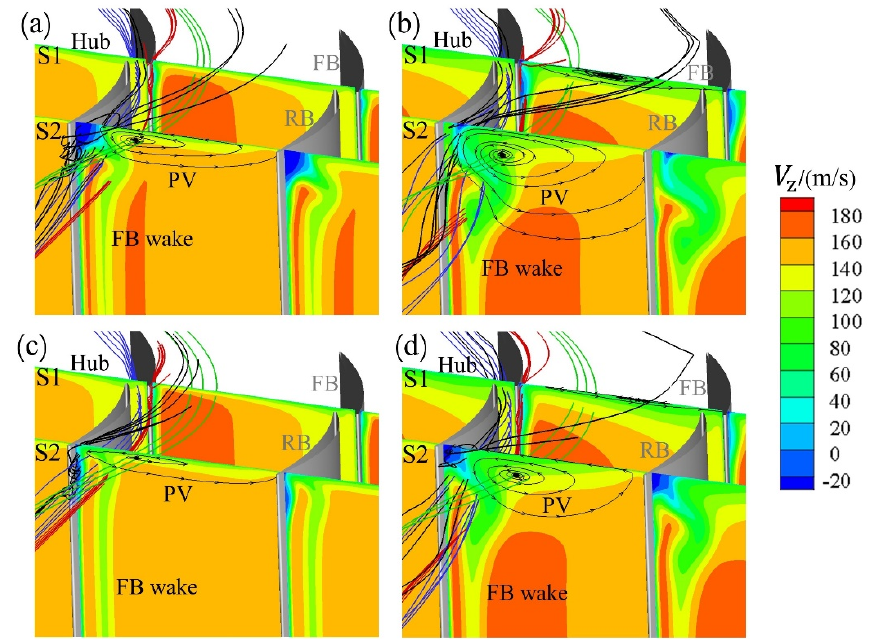
Figure 20. The 3D streamlines of the blade passage and V z contours at 4 ◦ incidence angle under different IBL conditions: ( a ) 0 mm collateral; ( b ) 5 mm collateral; ( c ) 0 mm skewed; ( d ) 5 mm skewed.